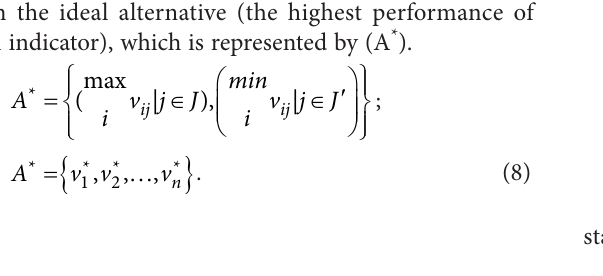
Table 7. Weighting the criteria through the ANP network analysis process (source: authors)